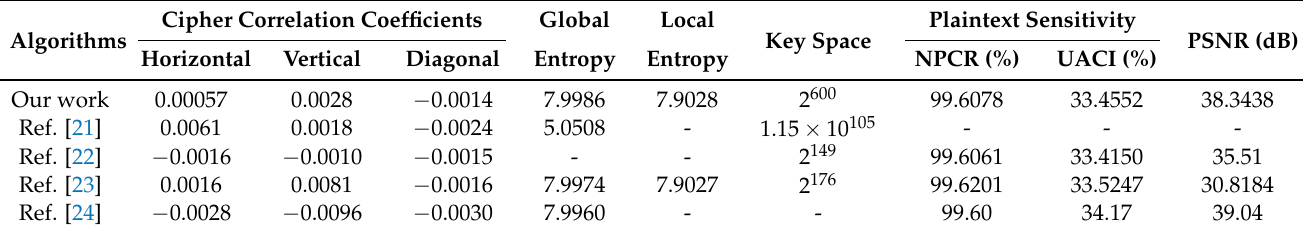
Table 9. The comparison